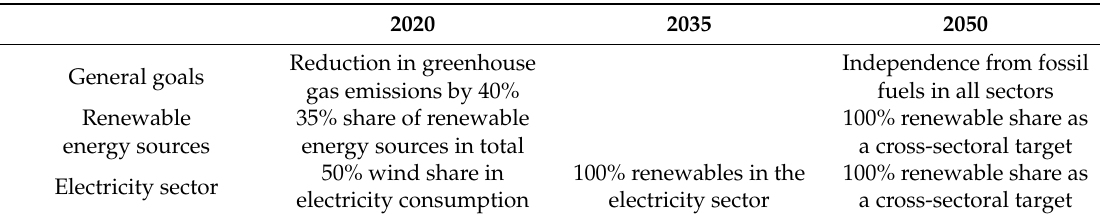
Table 2. Periodic countermeasures against wind power volatility defined by Denmark’s transmission system operator (TSO) [5].